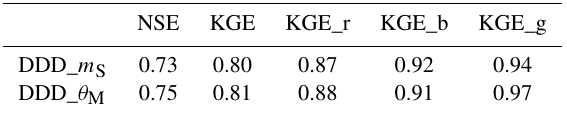
Table 2. Mean values of skill scores obtained with simulating with Table 4. Significant Spearman correlation ( p value < 0.01) between catchment characteristics and the shape, α , and scale, β , parameters relation, KGE_b the bias error and KGE_g the variability error. All of the distribution of (cid:51) . The correlations are based on estimated skill scores have an ideal value of 1. model parameters for 83 Norwegian NSE KGE KGE_r KGE_b KGE_g